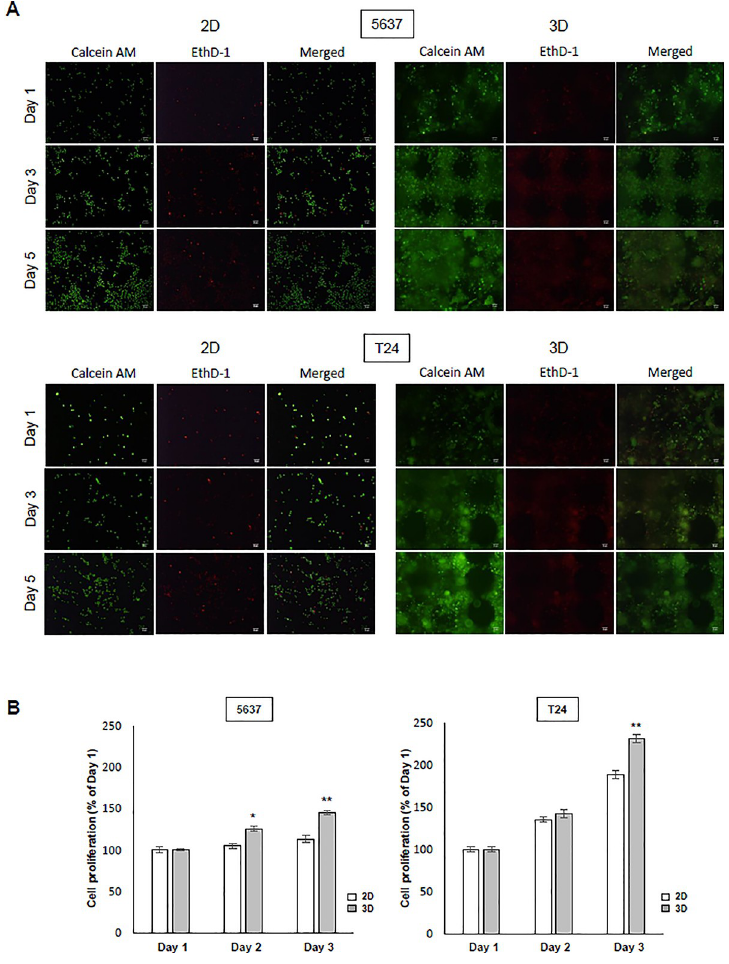
Fig 3. Morphological changes in the cells of printed constructs and comparison of 2D and 3D cell proliferation. (A) To confirm the morphology of the bladder cancer cells, 1 × 10 5 5637, T24 cells were seeded on a 60-mm plate dish, stained with fluorescence markers, and observed with a microscope for 5 days. For 3D cell culture, 1 × 10 5 cells were mixed in 1 ml solution and then the construct was printed. The cells (1 × 10 5 ) were used in a total of 100 μ l solution to print one structure. Live/dead staining in the 2D and 3D cell culture environment confirmed cell viability. Cells were stained with Calcein AM (2 μ M) and EthD-1 (4 μ M) and observed after 1, 3, and 5 days with a fluorescence microscope. (B) The 5637 and T24 human bladder cancer cells were seeded on 60-mm plates for 1, 2, and 3 days. Cell proliferation was determined by the CCK-8 assay in bladder cancer cells. � p < 0 . 05 , �� p < 0 . 01 , ratios were compared between 2D and 3D cultures on each day. Data are the mean ± SEM (n =